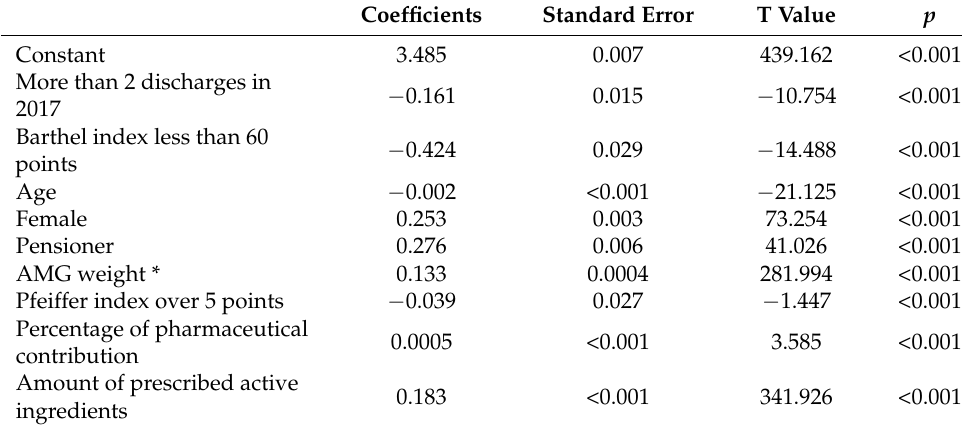
Table 4. Relation between total cost and independent